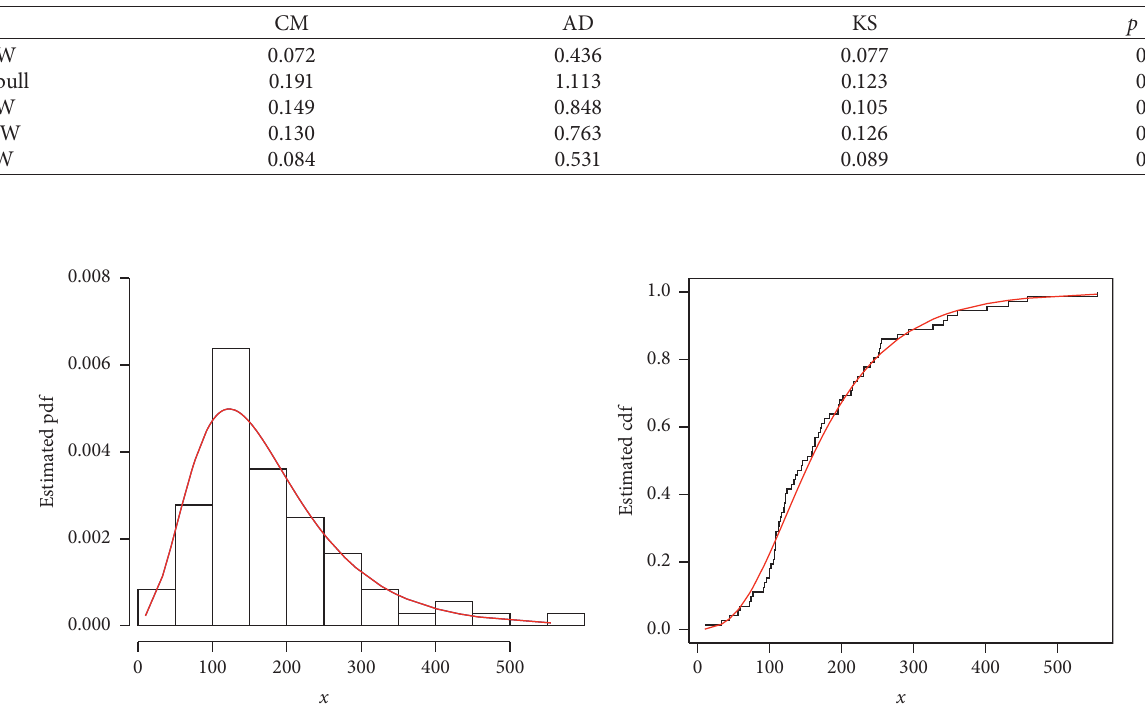
Figure 3: Plots for the estimated pdf and cdf of the NE-W distribution for data